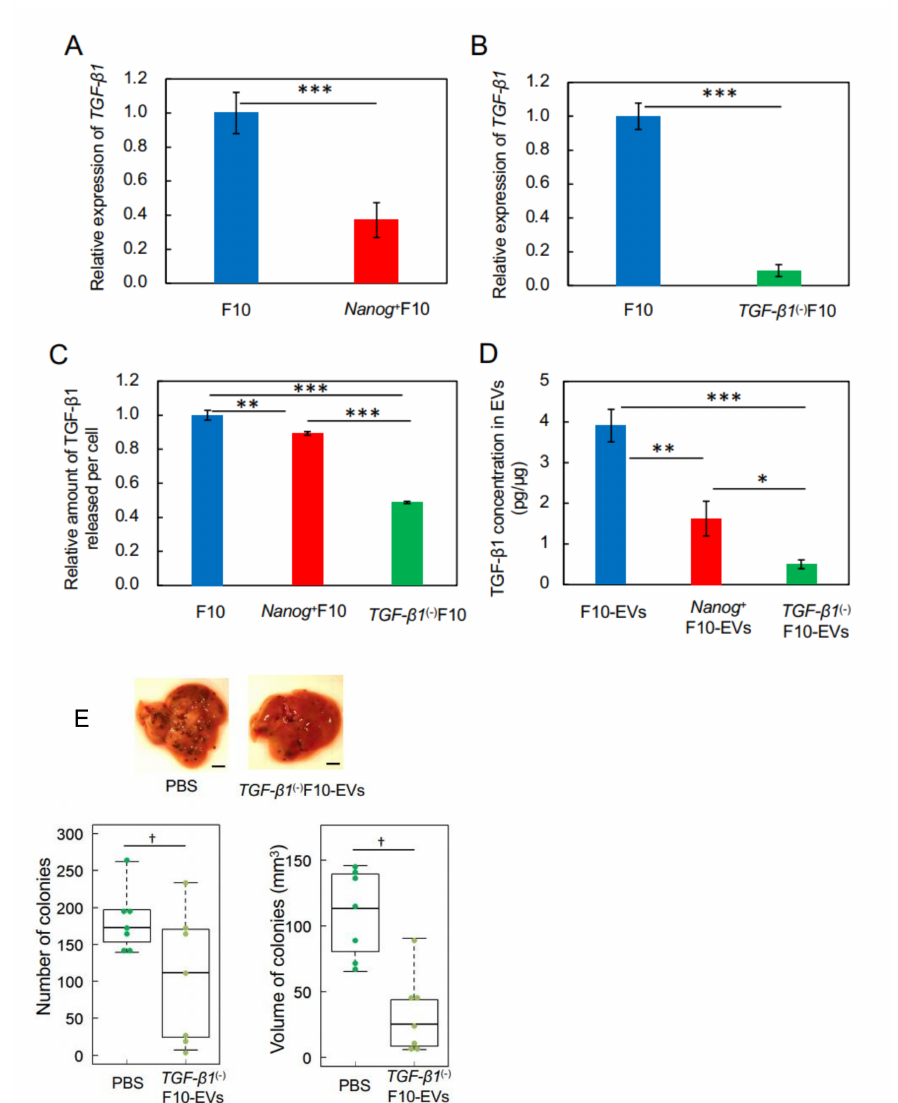
Figure 3. Effects of pre-administration of TGF- β 1 (-)F10-EVs on metastatic potential. ( A , B ) Decrease of TGF- β 1 expression in Nanog + F10 cells and in TGF- β 1 (-)F10 cells, respectively, analyzed by quantitative RT-PCR and shown as the relative values to that in F10 cells. mean ± SD, for n = 3. ( C ) The amount of TGF- β 1 protein released into the culture medium from Nanog + F10 cells and TGF- β 1 (-)F10 cells, respectively, analyzed by ELISA and shown as the value per cell that was counted immediately after collecting the culture medium. Results are shown as the relative values to that from F10 cells. mean ± SD, for n = 3. ( D ) TGF- β 1 concentrations in EVs analyzed by ELISA. mean ± SD, for n = 3. ( E ) Effects on the images, number, and volume of metastatic colonies after injection of TGF- β 1 (-)F10 cells. Scale bar, 5 mm; n = 7. ***: p < 0.001, **: p < 0.01, *: p < 0.05, †: p <